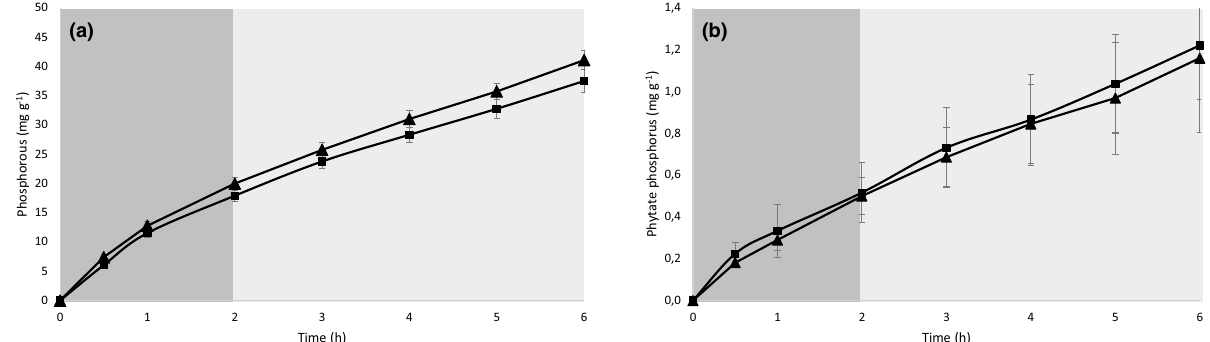
Figure 2. Total phosphorus ( a ) and phytate phosphorus ( b ) release (mg g −1 of diet) from control (filled black square) and BSG0.4 (filled black triangle) diets under the simulated conditions of European seabass digestive tract. Stomach and intestinal digestion are represented in dark and light grey, respectively. Values are presented as the mean of the cumulative values ± standard